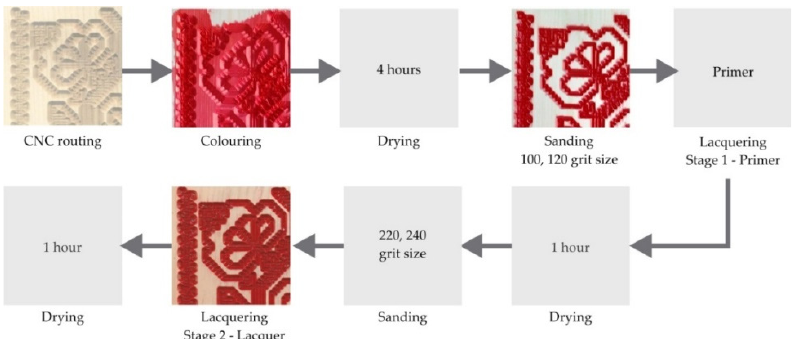
Figure 6. Technological process of coloring and coating the wood surface after CNC routing.